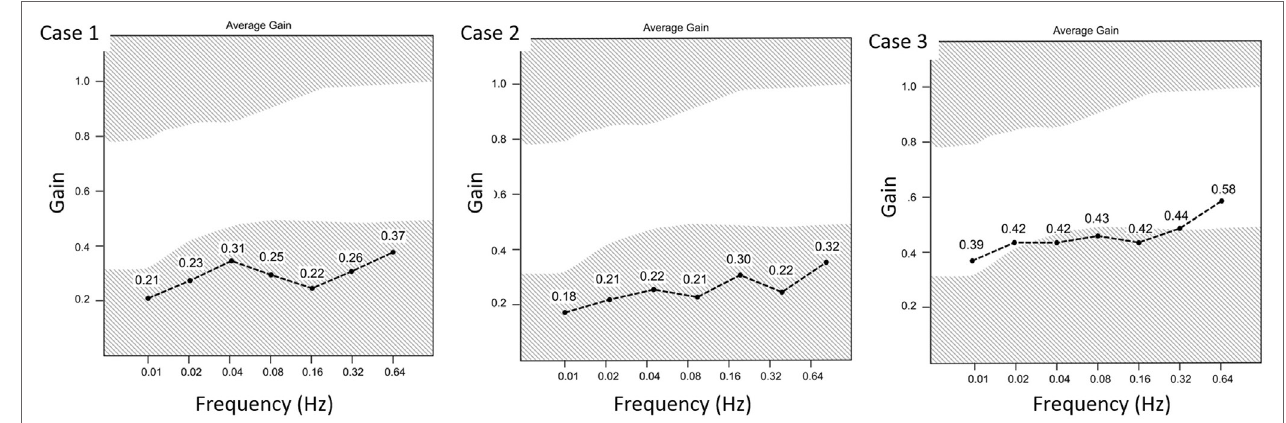
FIgURe 2 | The summary of average gain values at frequencies between 0.01 and 0.64 Hz sinusoidal rotations. The gain values were below normal for all frequencies tested for Cases 1 and 2 and were reduced at most frequencies for Case 3.